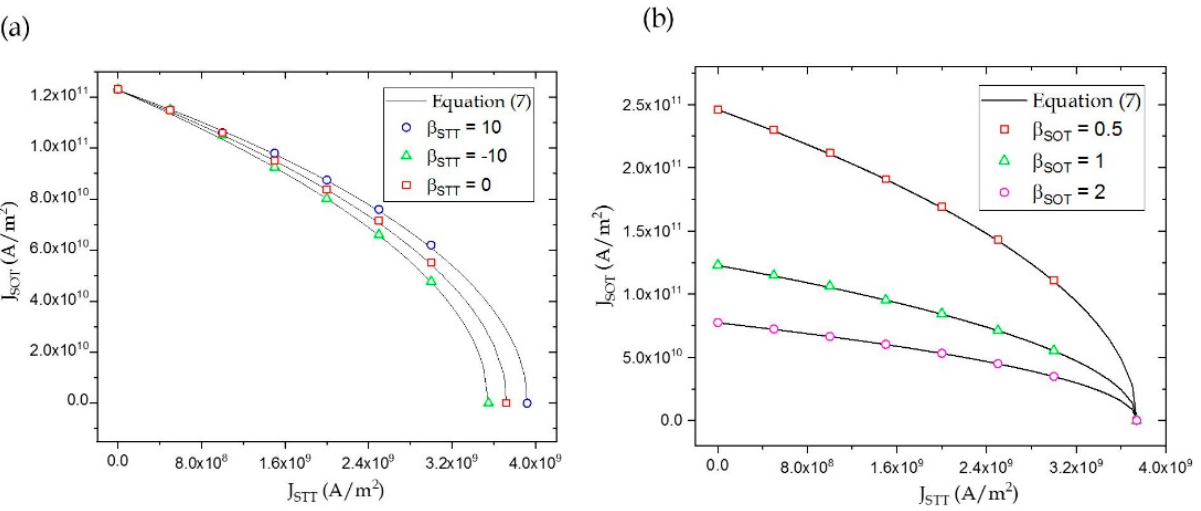
Figure 4. The solid line represents boundary Equation (7) above switching takes place from P to AP state ( a ), with changing β STT and ( b ) with increasing β SOT . Symbols represent results obtained from micromagnetic